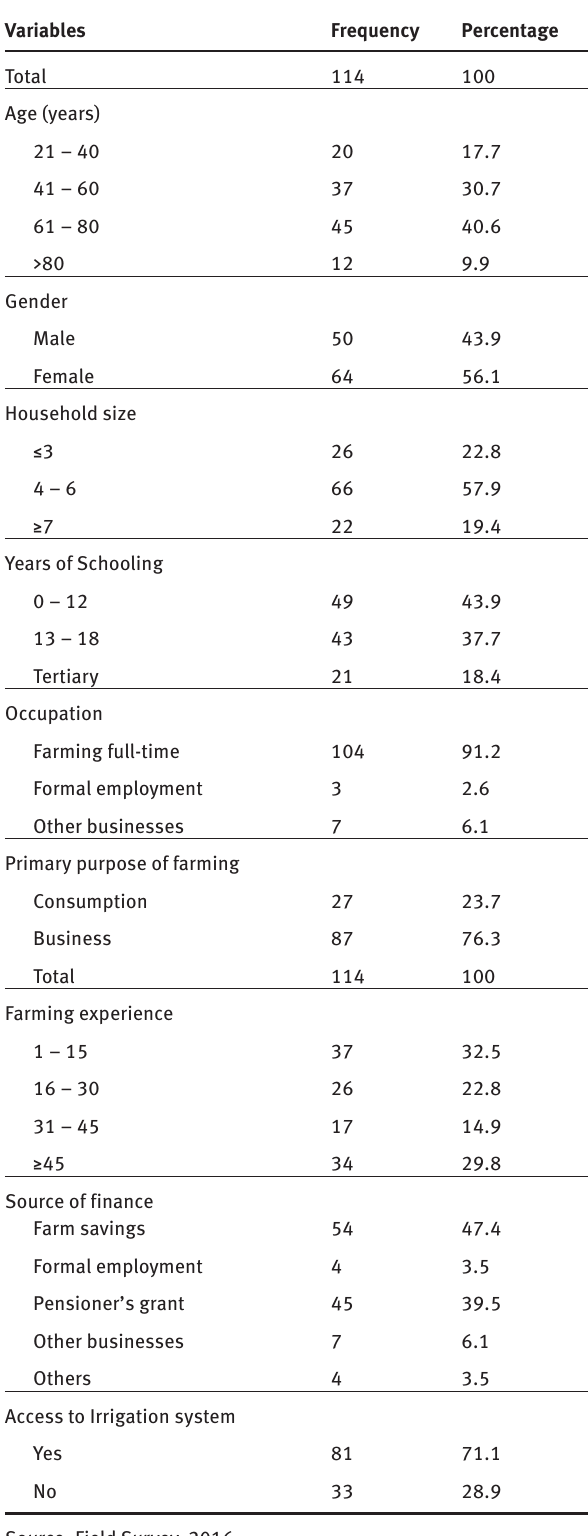
Table 3: Frequency distribution of demographic characteristics of AIV farmers in Vhembe